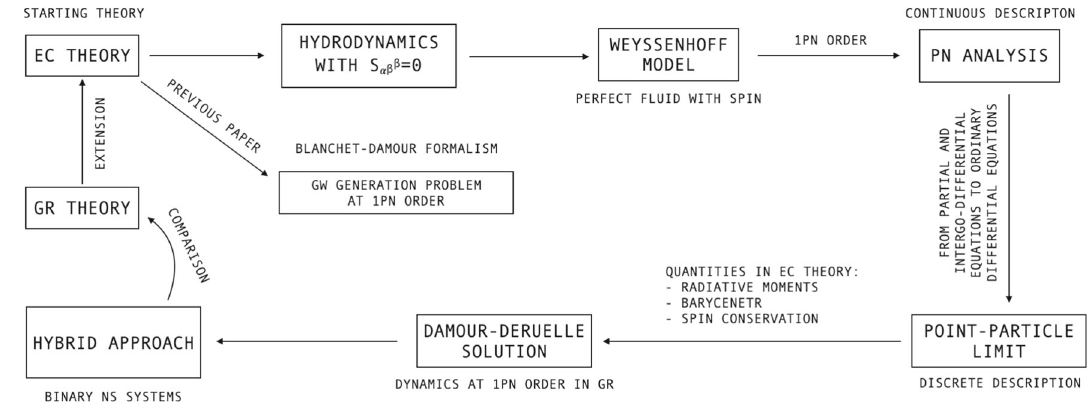
Fig. 3 Flowchart of the paper. “Previous paper” refers to Ref.